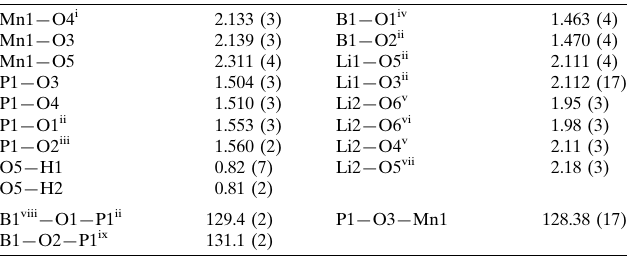
Selected geometric parameters (A˚ , (cid:4) ).